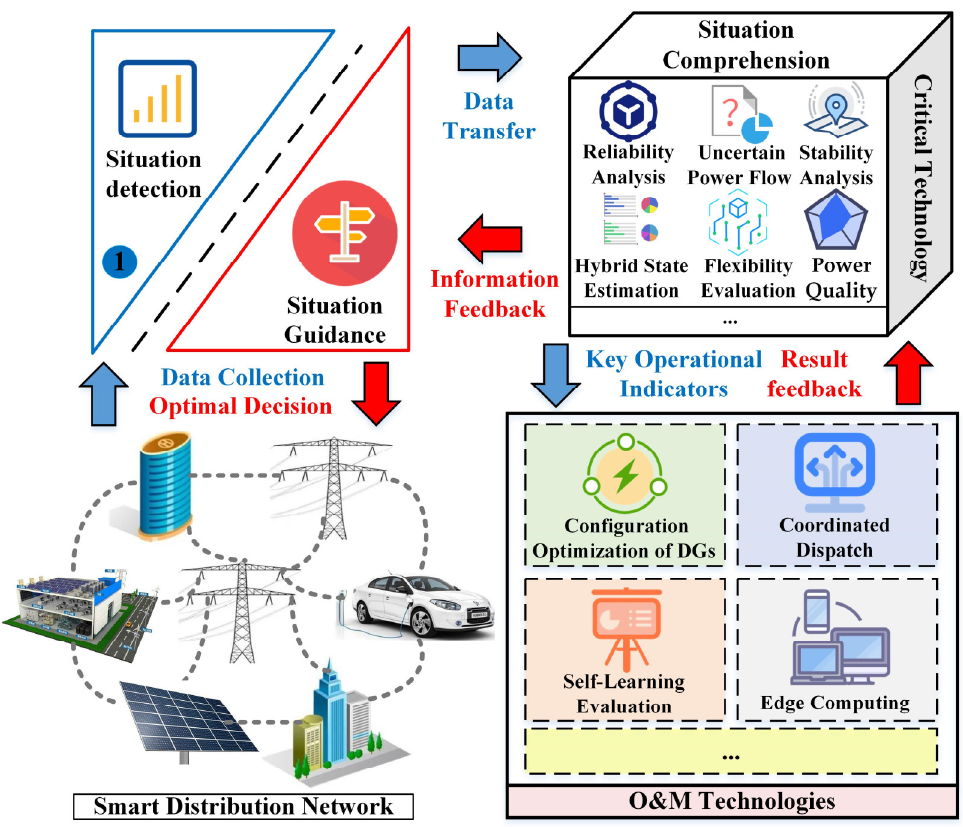
Figure 3. The implementation framework of situation comprehension.